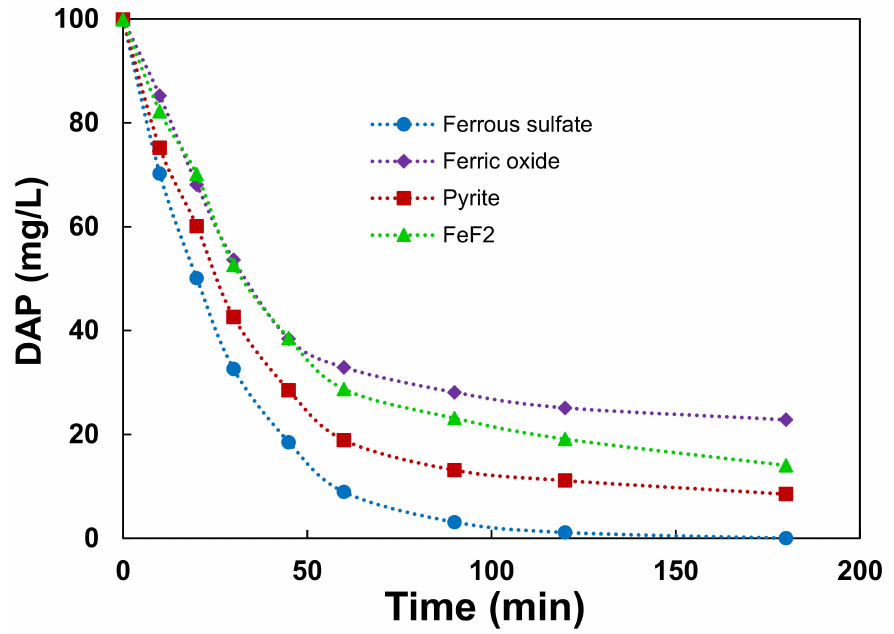
Figure 4. Effect of the iron source on the degradation of DAP kinetics during the Fenton process (H 2 O 2 /Fe 2+ ). Experimental conditions: [DAP] 0 = 100 mg/L; [H 2 O 2 ] = 1000 mg/L; [Fe 2+ ] = 50 mg/L; pH =